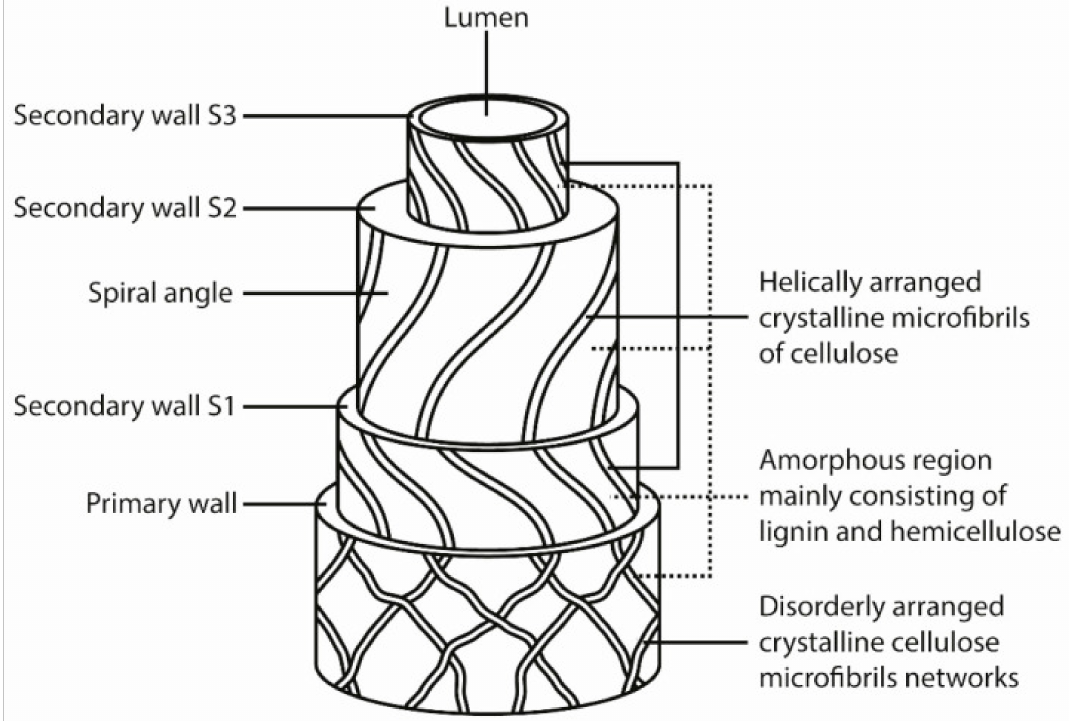
Figure 6. General structure of a natural fiber. Reprinted with permission from Elsevier